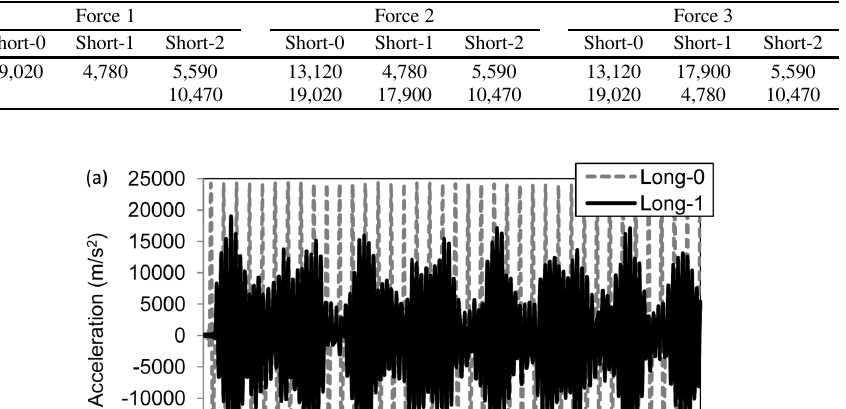
Table 9 Excitation frequencies (Hz) observed in FFT response of acceleration results obtained from the short structural models with three different applied impact forces. Frequencies are given in descending order of their magnitude